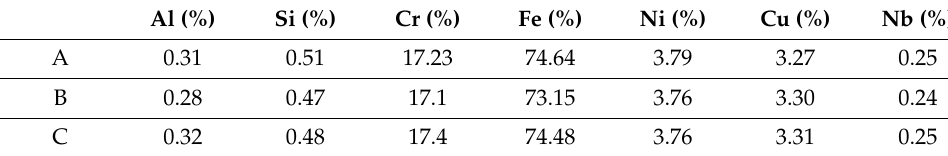
( a ) ( b ) ( c ) Figure 12. Tooth B15—the nucleation zone is remarked in ( a ), where large fusion defect (about 240 μm deep) with unmelted particles is clearly visible on the outer surface ( b and c ). 6. Results Discussion